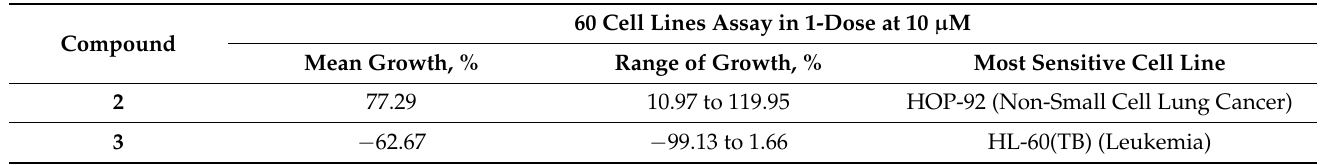
Table 1. In vitro anticancer activity in 60 human tumor cell lines for compounds 2 and 3 at 10 µ M.